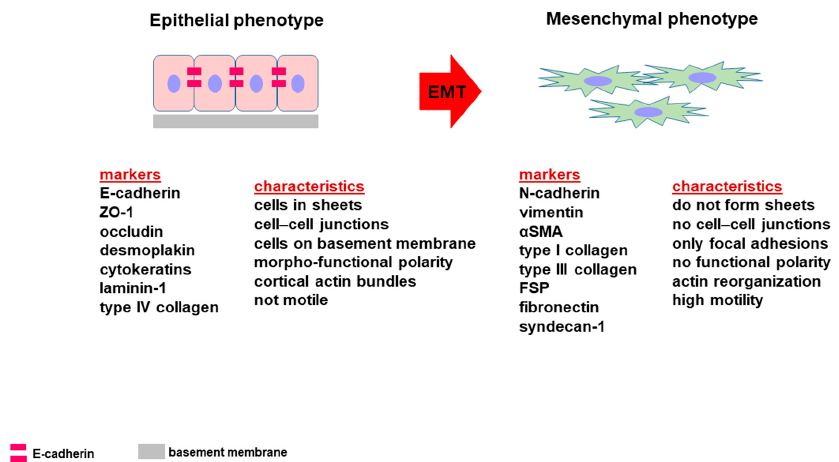
Figure 2. Diagram showing the morpho-functional phenotypic characteristics of epithelial and mesenchymal cells. The “proteome” related to EMT is based on the loss of some epithelial markers and the acquisition of a mesenchymal phenotype.